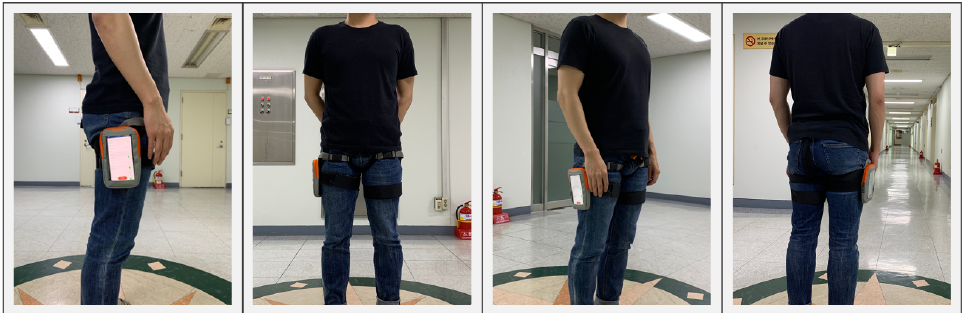
Figure 5. Placement of the smartphone used for data